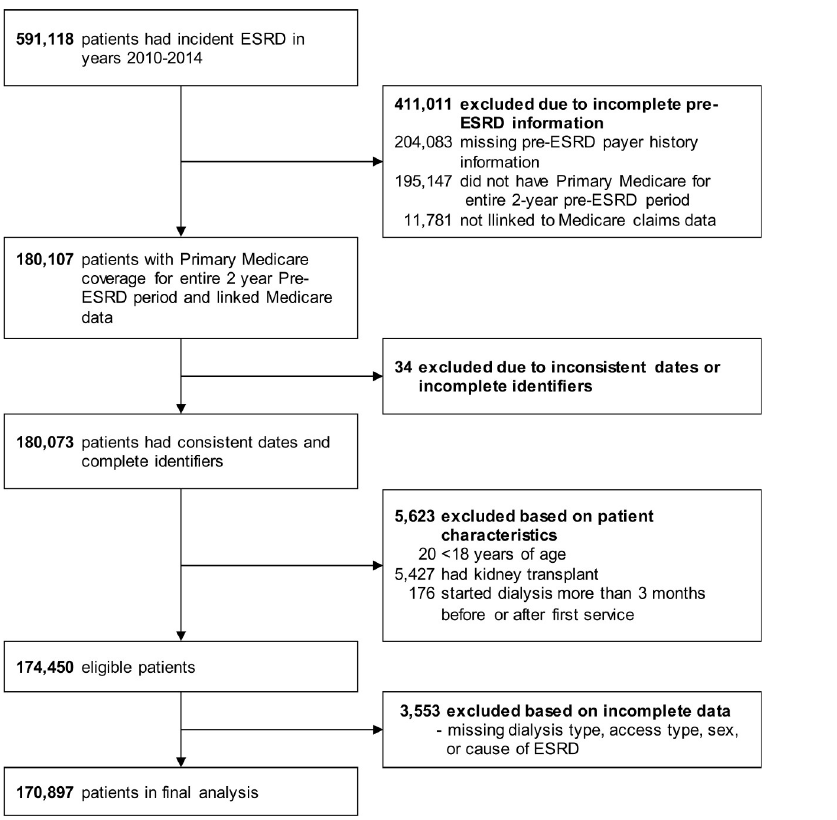
Fig 1. Flow chart describing the derivation of the study